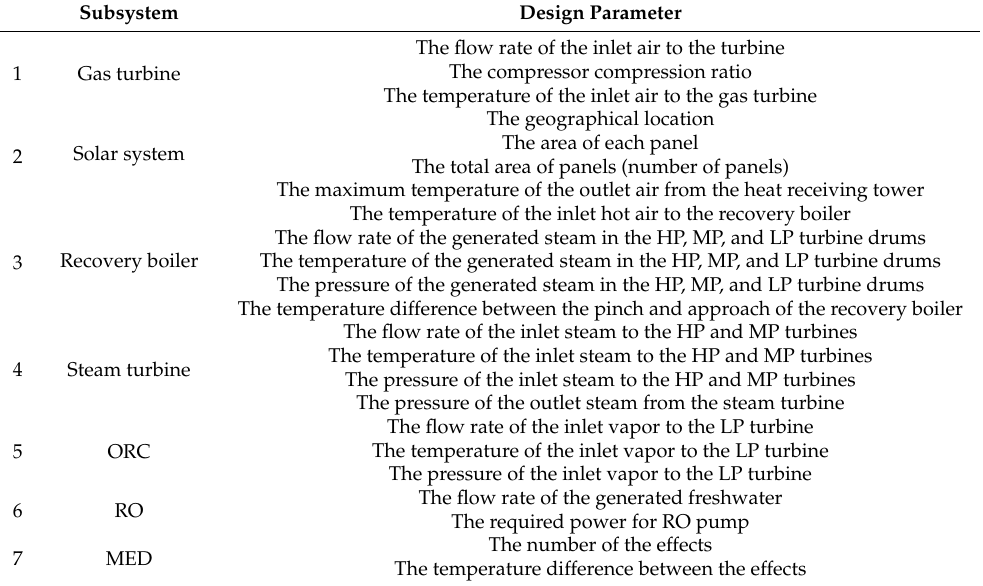
Table 2. Important variables in the calculation of the objective